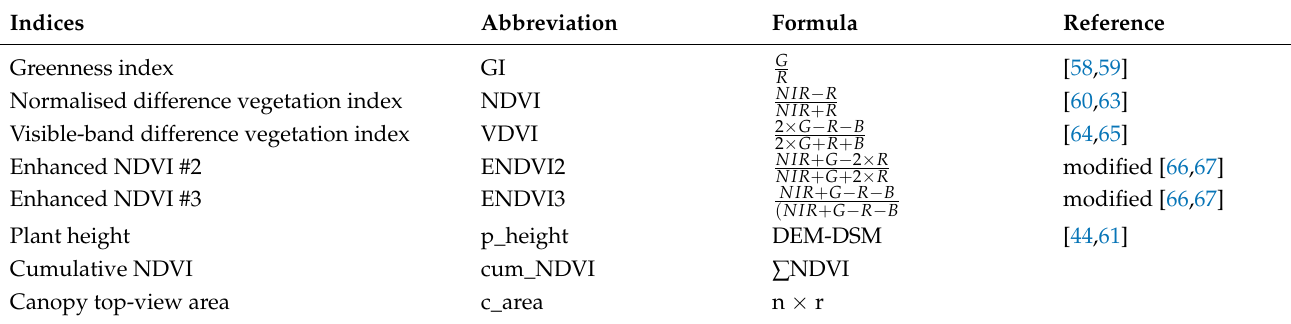
Table 1. The list of spectral and structural features retained after the feature filtering processes, i.e., the removal of non- significant and highly collinear features. Note: R, G, and NIR represent the spectral bands red, green and near infrared, respectively. n and r represent the number of pure-canopy pixels and the spatial resolution of the pixels, respectively. Indices Abbreviation Formula